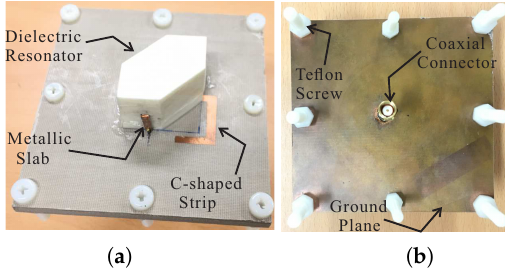
Figure 7. Photograph of the proposed antenna: ( a ) panoramic view and ( b ) back view.